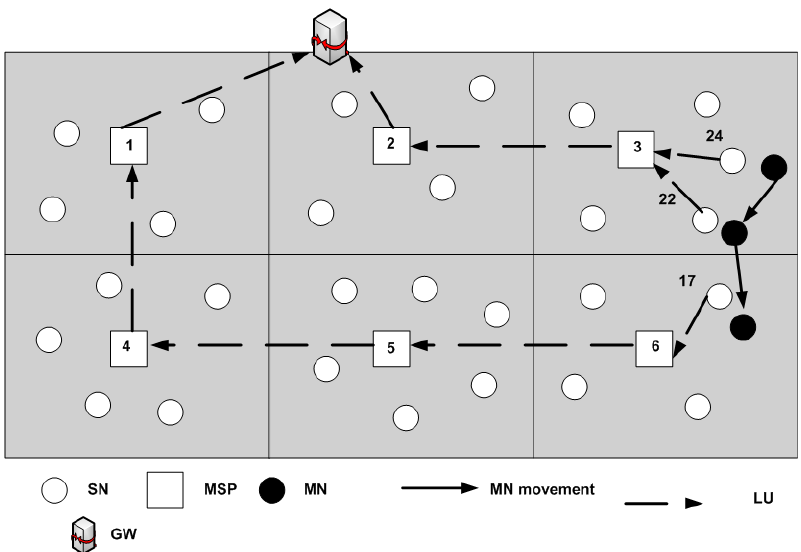
Figure 10. Updating binding information with